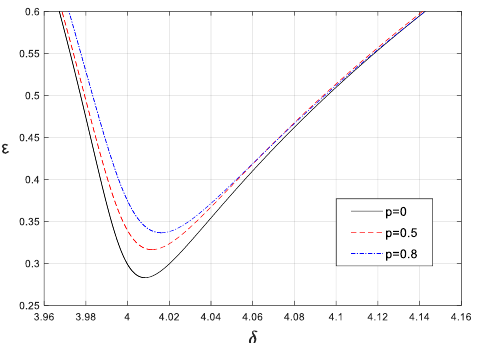
4  = ). Figure 11. The effects of p on stability boundaries ( δ 4  = ). = 4 0 0 0